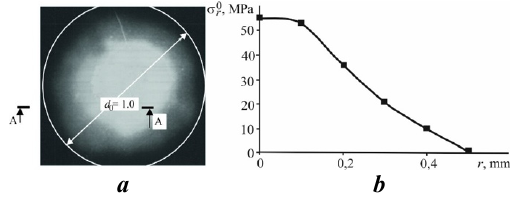
Figure 9 – Chemographic image of the stressed zone of hydraulic influence (a) (top view, from the side of the jet)